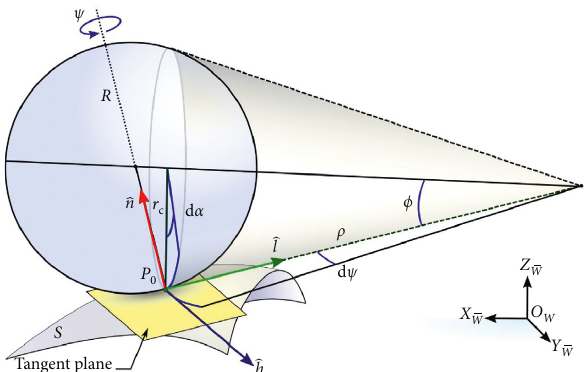
Figure 5: Schematic diagram of a spherical robot using rolling and steering (RS) action